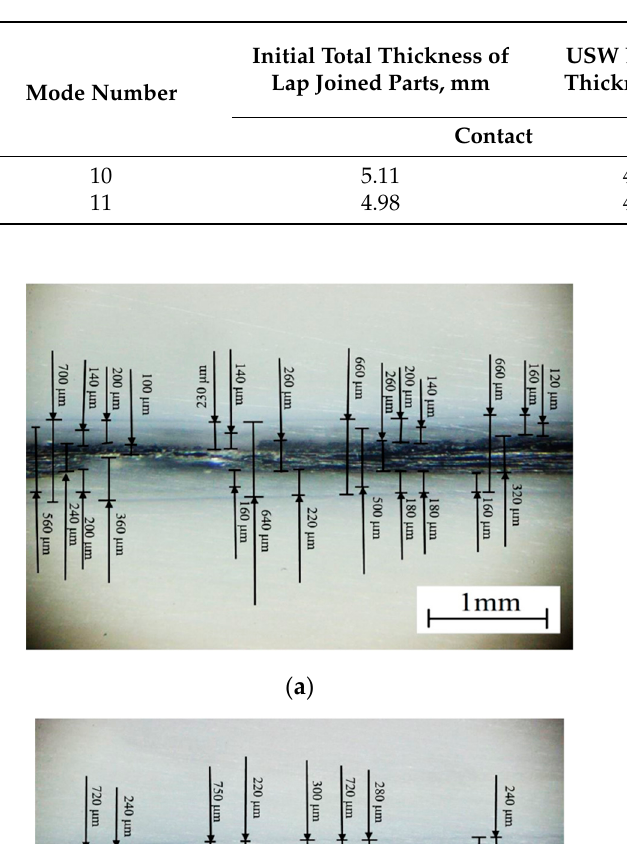
Table 7. The dimensional characteristics of the USW lap joints obtained with the parameters optimized by ANN simulation.